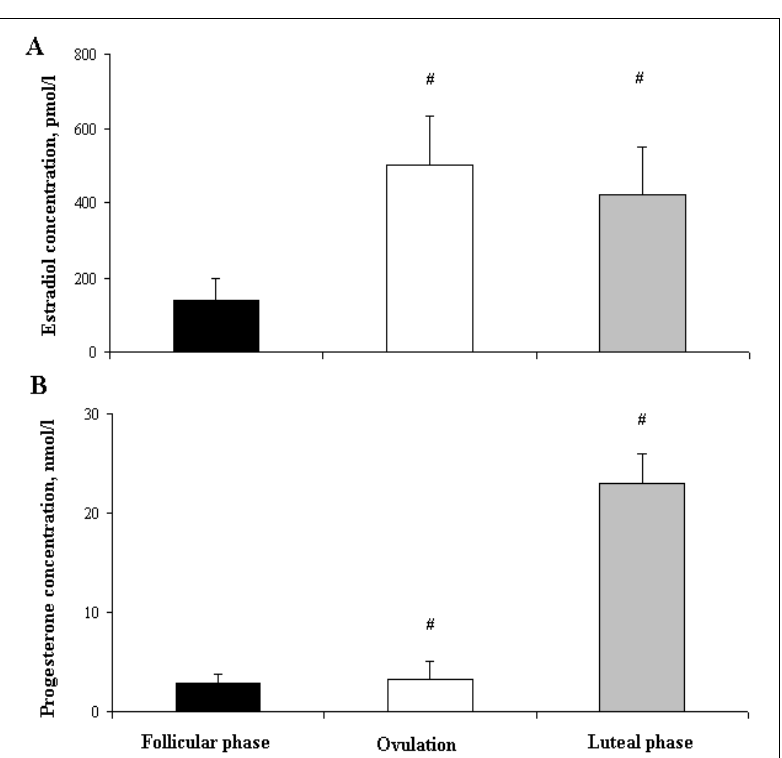
Note: # – compared to the follicular phase indices (p < 0.05). Figure 3. Female basketball players’ estradiol (A) and progesterone (B) concentration in blood during follicular, ovulation and luteal phases